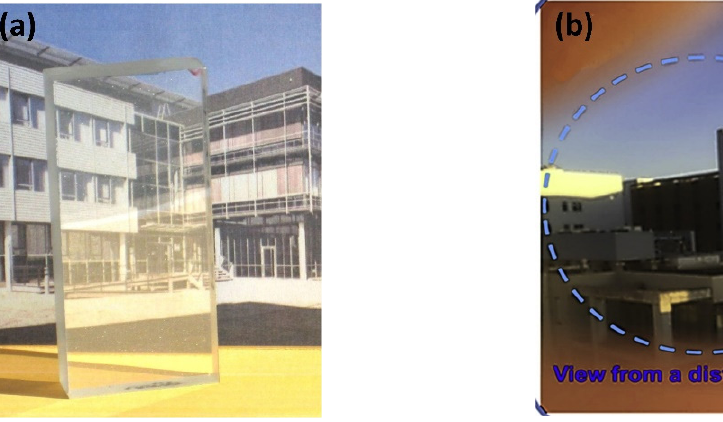
Figure 14. Transparent armor nano-ceramics; ( a ) MgAl 2 O 4 transparent nano-ceramics, 12 mm thick, created through pre-sintering in air and HIP methods [83]. Reprinted with permission from Ref. [83]. Copyright 2014, copyright ScienceDirect. ( b ) a photograph revealing the transmittance of the Mg- γ -AlON transparent ceramic after HIP treatment [96]. Reprinted with permission from Ref. [96]. Copyright 2019, copyright ScienceDirect.